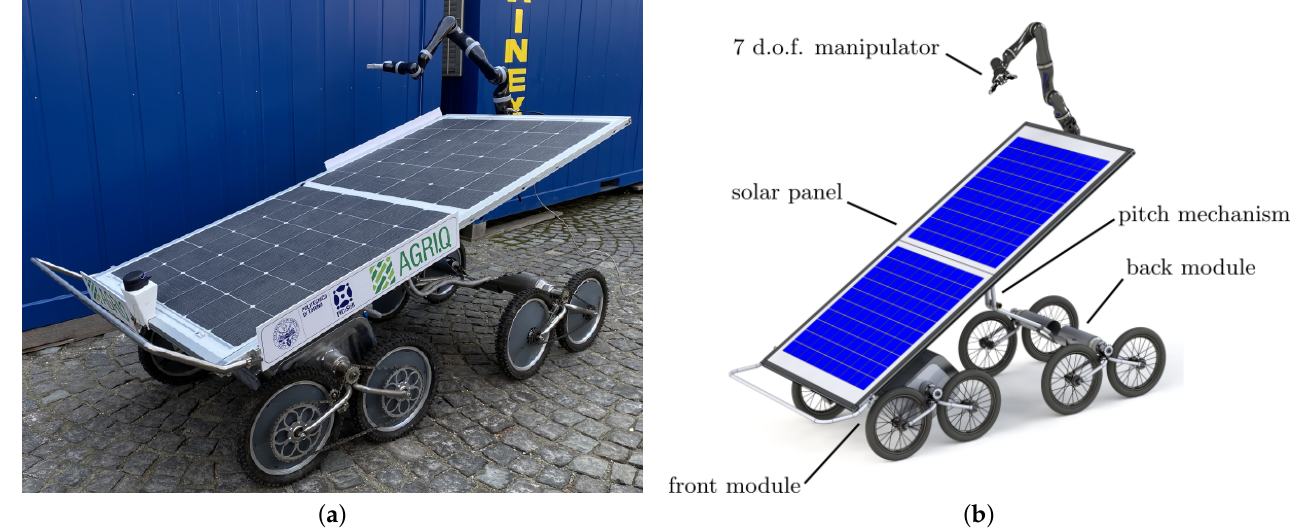
Figure 2. ( a ) The Agri.Q mobile manipulator prototype developed at Politecnico di Torino. ( b ) Render of the prototype to highlight its fundamental